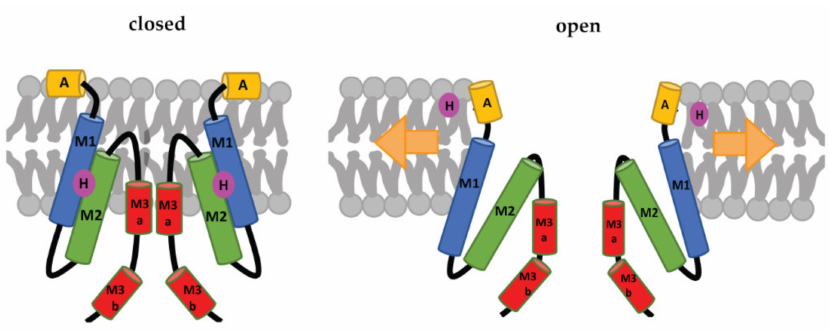
Figure 3. Schematic representation of the MscS-gating mechanism proposed by Reddy et al. [34]. Arrows represent ‘force-from-lipids’. The relative sizes of the domains are not to scale. A: Anchor, M1, M2, M3a, and M3b: transmembrane domains, H: hook lipid. The figure shows a model, in which the hook lipid moves out of its binding pocket upon membrane stretch and corresponding channel opening. An alternative model, where the hook lipid stays situated between M1 and M2, was not yet ruled out